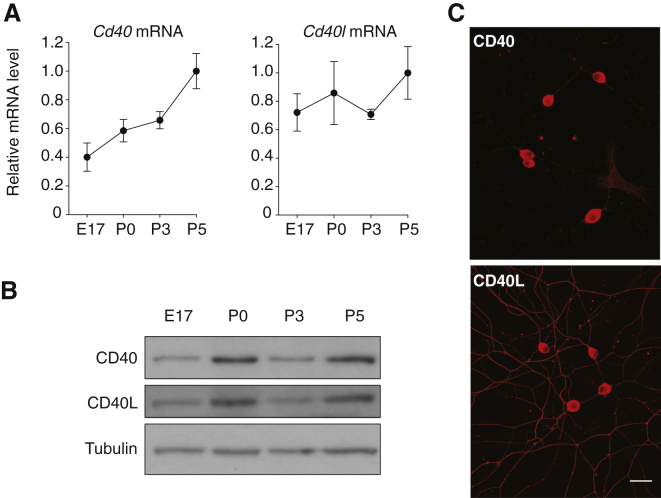
SCG Neurons Express CD40 and CD40L(A) Levels of Cd40 and
Cd40l mRNA relative to reference mRNAs in SCG of different
ages. The data are normalized to a value of 1.0 at the peak of expression at P5. Mean
± SEM of data from three separate sets of ganglia at each age is
shown.(B) Representative western blot of lysates of SCG of
different ages.(C) Images of representative P3 SCG neurons cultured for
24 hr in medium containing 1 ng/ml NGF labeled with either anti-CD40 or anti-CD40L.
The scale bar represents 50 μm.